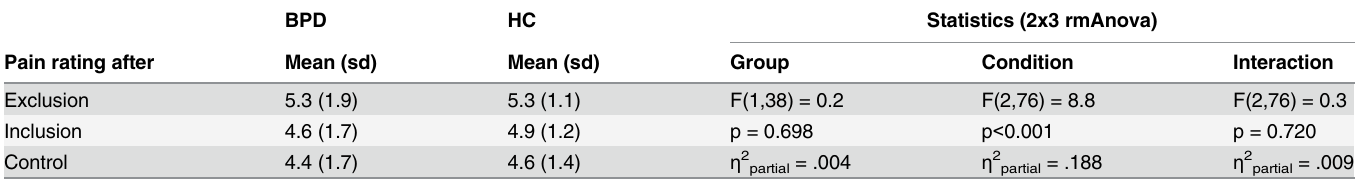
Table 2. Subjective pain ratings following the different cyberball conditions together with results of the